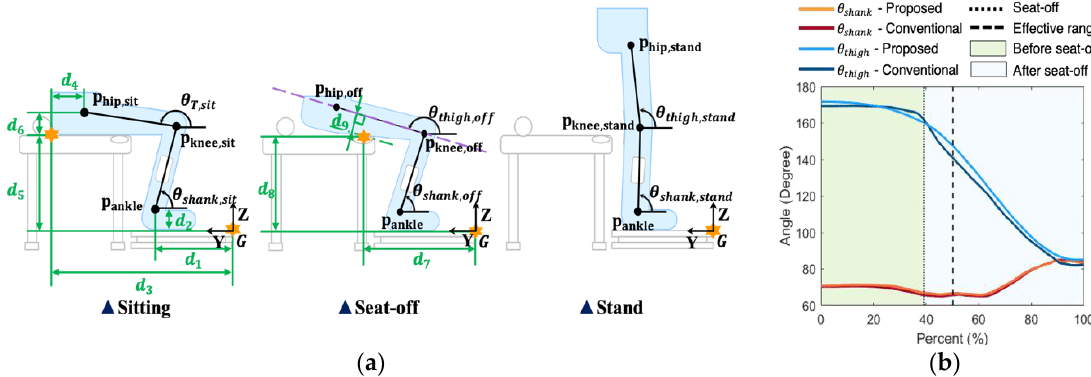
Figure 2. Kinematic model; ( a ) schematic diagram, ( b ) expected result of the kinematic model. Note that the environmental parameters (green) are defined by distances between landmarks (orange stars) and joint center and the purple dashed line at seat-off is the thigh segment line that passes through the knee joint position.